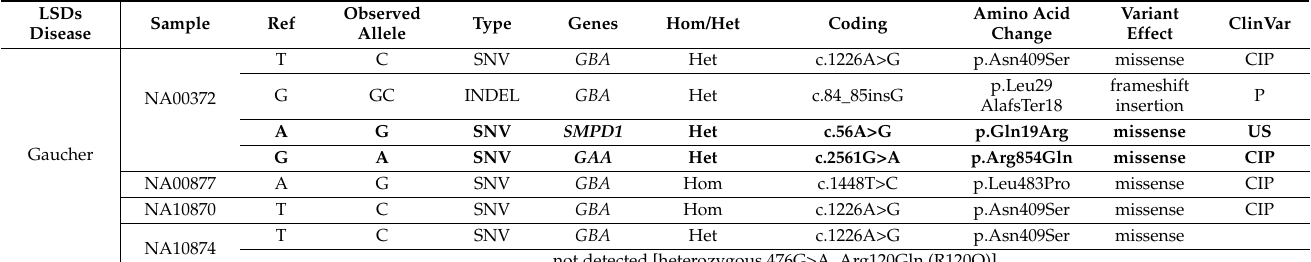
Table 1. Detected and missed pathogenic variants in analyzed samples and new